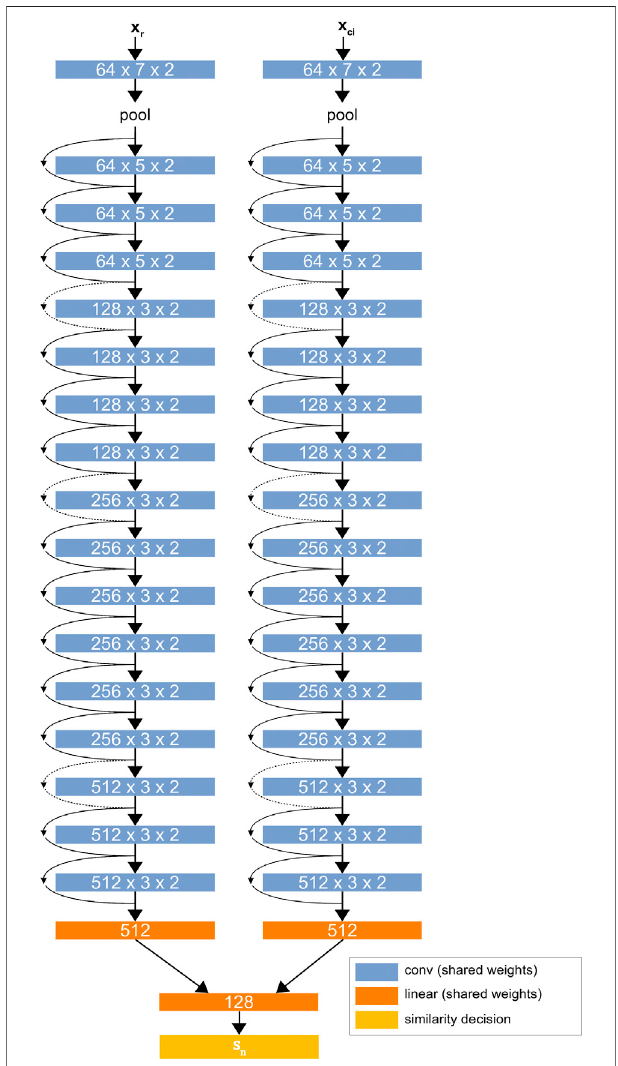
FIGURE 2 | The D-CNN architecture. The two ResNet34 (He et al., 2015) networks share the same weights, forming a Siamese neural network. The linear layers at the end of the network fi nd a difference between the two networks ’ values for each patch and give a binary similarity decision s n based on this difference. The goal of training the D-CNN is to maximize its ability to make correct similarity